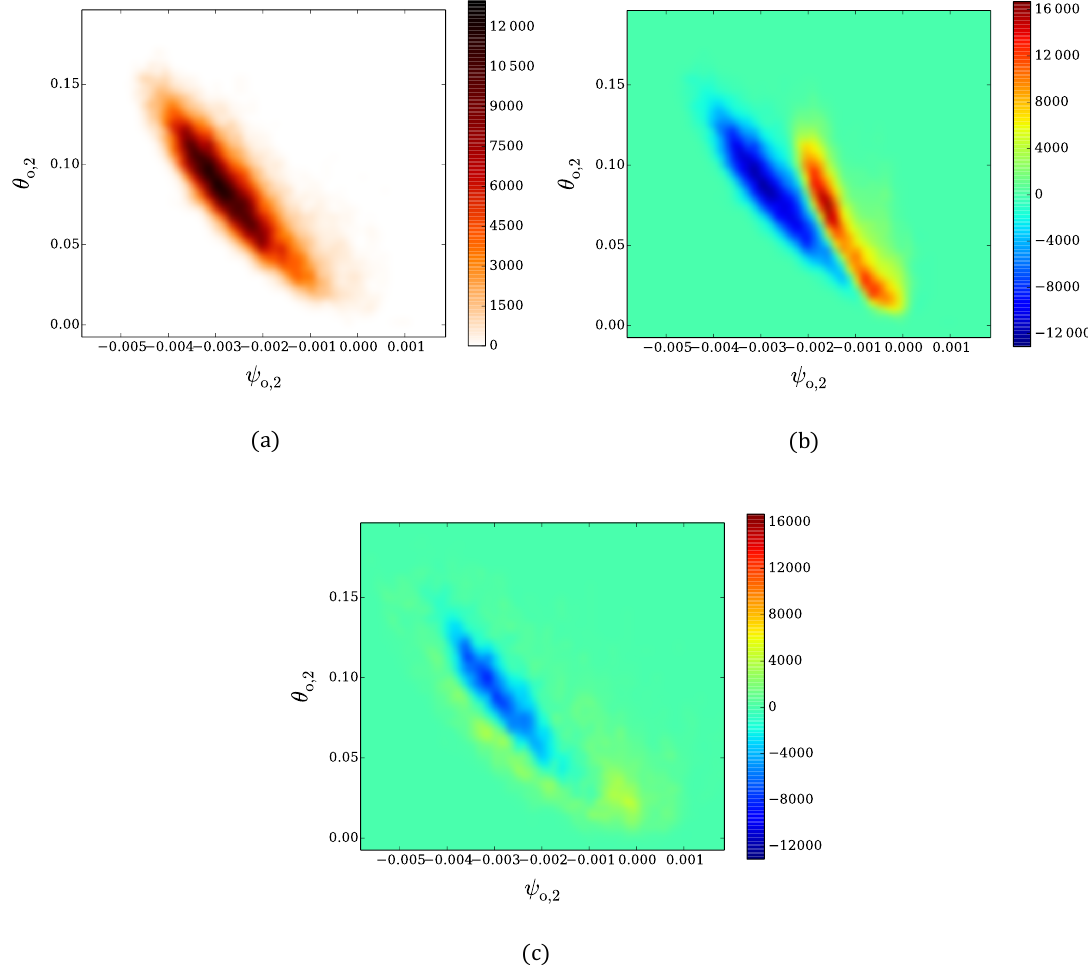
Figure 12. Parameterization of the 5 × 5 model version with the MTV parameterization. (a) Two-dimensional probability density function (PDF) of the fully coupled dynamics with respect to the two dominant oceanic modes. (b) Anomaly of the PDF of the uncoupled dynamics with respect to the fully coupled one. (c) Anomaly of the PDF of the MTV dynamics with respect to the fully coupled one.